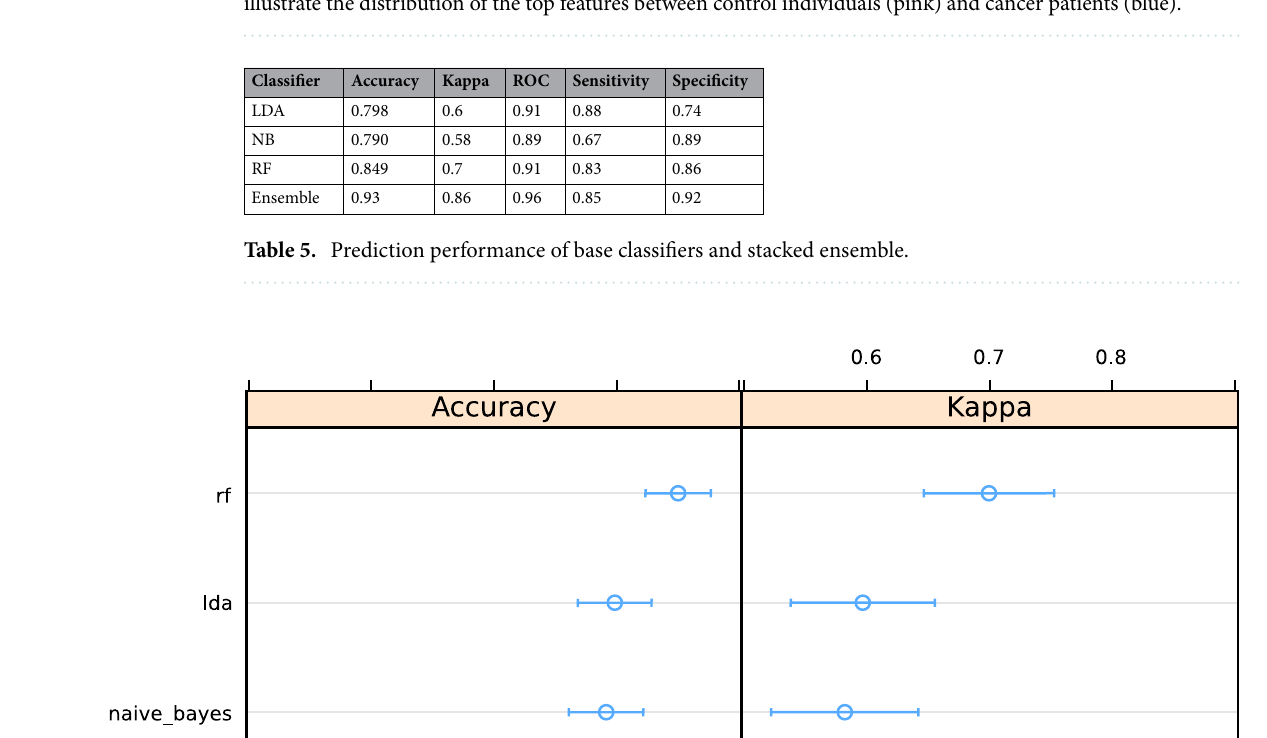
Figure 1. Density plots for the five most important HRV features selected by the RFE method. The density plots illustrate the distribution of the top features between control individuals (pink) and cancer patients (blue).